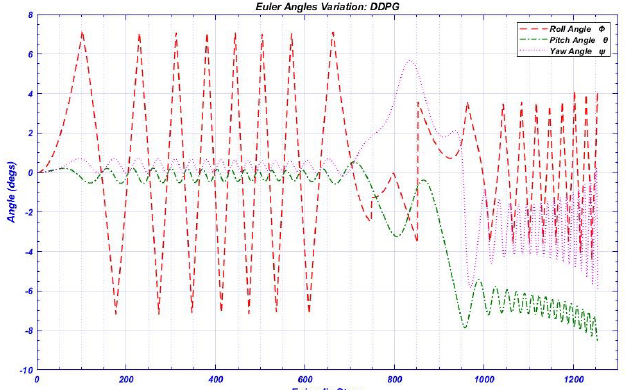
Figure 3. Euler Angles